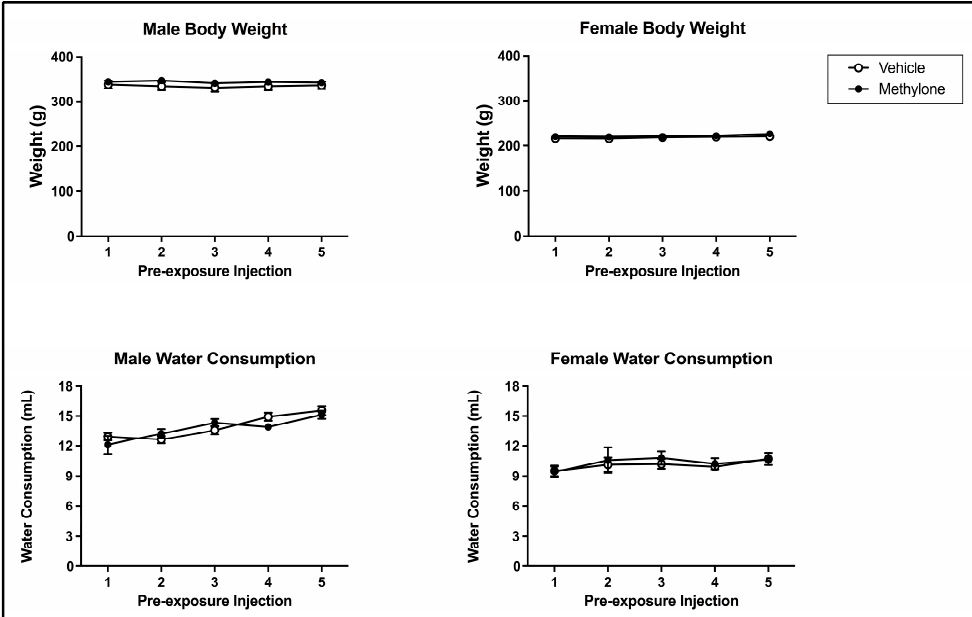
Figure 2. Mean (+/ − SEM) bodyweight (g; top ) and water consumption (mL; bottom ) of male ( left ) and female ( right ) subjects injected with saline (vehicle) or 10 mg/kg of methylone ( n = 16–17 per group for both males and females) on pre-exposure days.